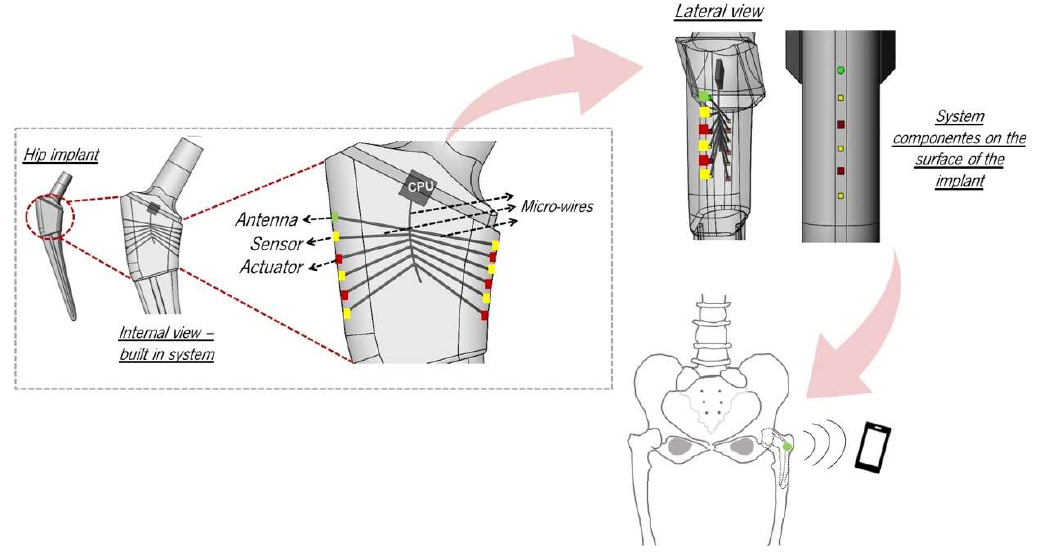
Figure 1. Schematic illustration of a hip implant with smart components printed on its surface in different views, highlighting the antenna. Modified from [32].